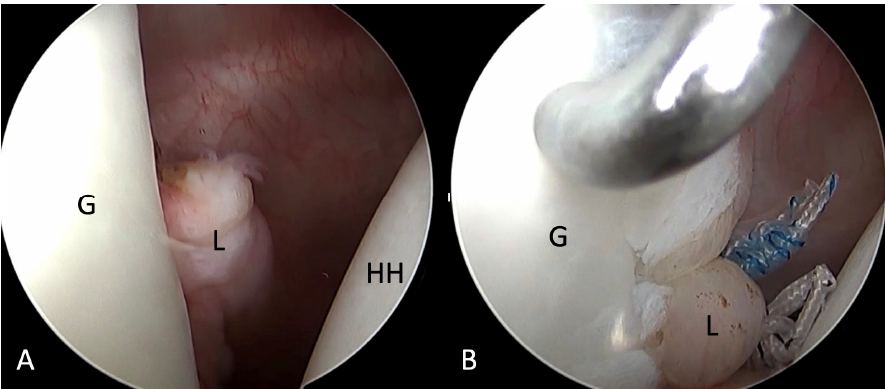
Figure 2. ( A ) Right anterior labroligamentous periosteal sleeve avulsion lesion ( B ) repaired with two double-loaded all-suture anchors. G, glenoid; HH, humeral head; L, labrum.